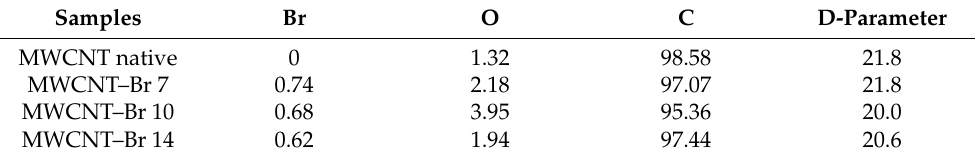
Table 2. Atomic concentration (at%) and D-parameter (eV) from XPS survey spectra.